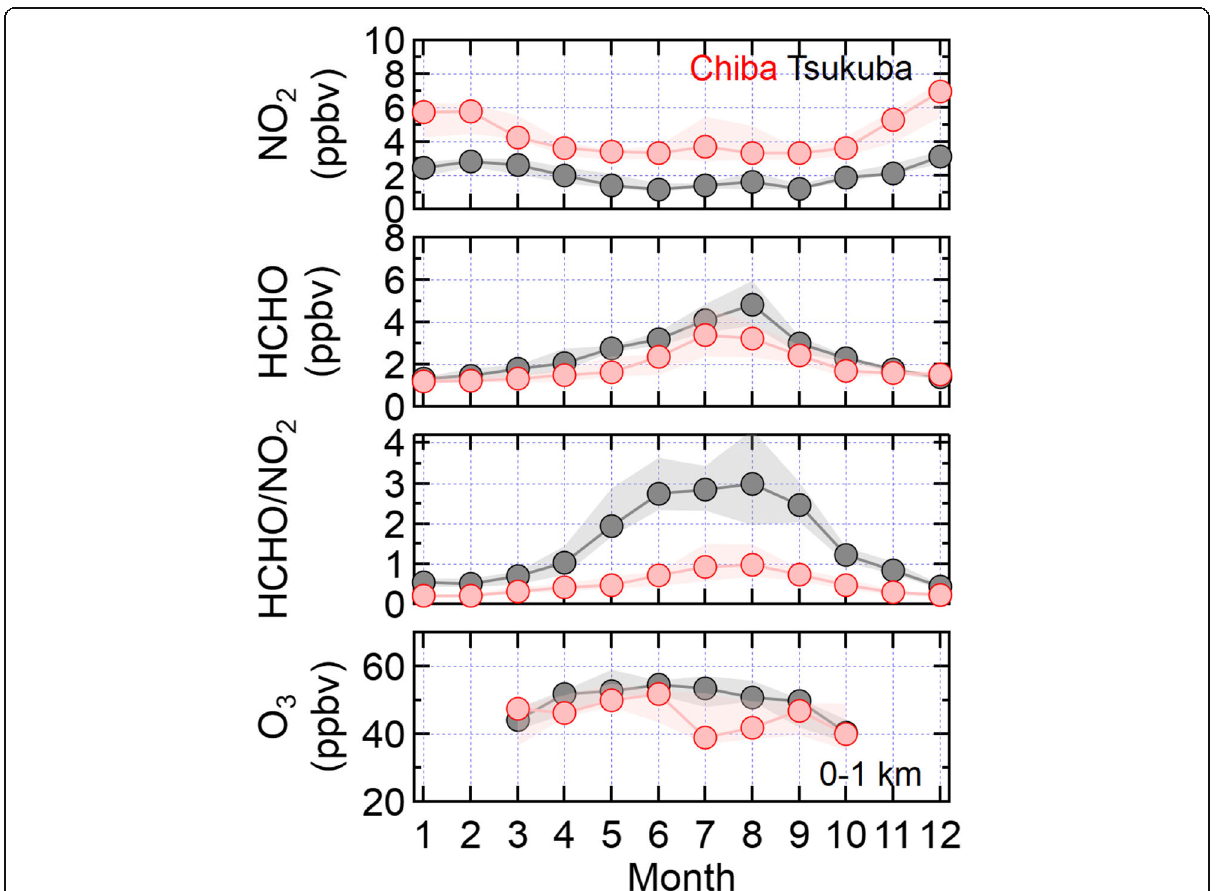
Fig. 4 Seasonal variations in NO 2 and HCHO concentrations, HCHO/NO 2 concentration ratio, and O 3 concentration for the lowest layer (altitude of 0-1 km) retrieved from MAX-DOAS observations at Chiba (red) and Tsukuba (black), Japan for 2013 – 2019. The O 3 data for January, February, November, and December were unavailable, because the amount of retrieved data at SZA < 50° with less influence by high-altitude O 3 was limited (see the text for more details). The median values of monthly means for the 7 years are shown. Shaded areas represent 67% ranges